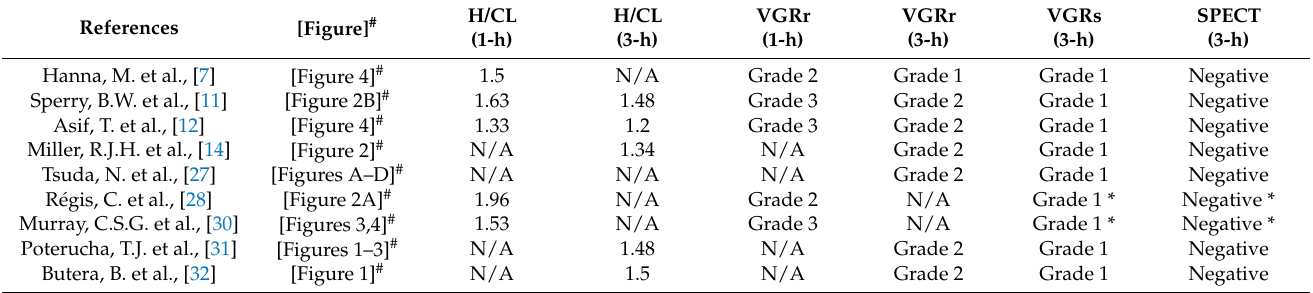
Table 3. “False positive” interpretations on 99m Tc-PYP planar images were re-evaluated by using our proposed 3-h semi-quantitative grading (relative to the upper segment of the sternum)